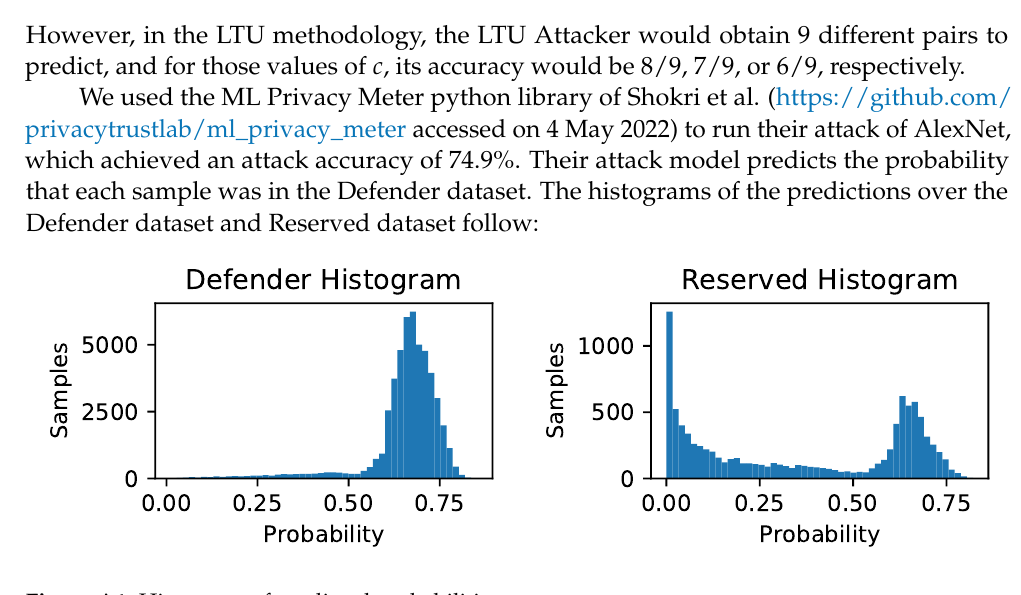
Figure A1. Histogram of predicted probabilities.